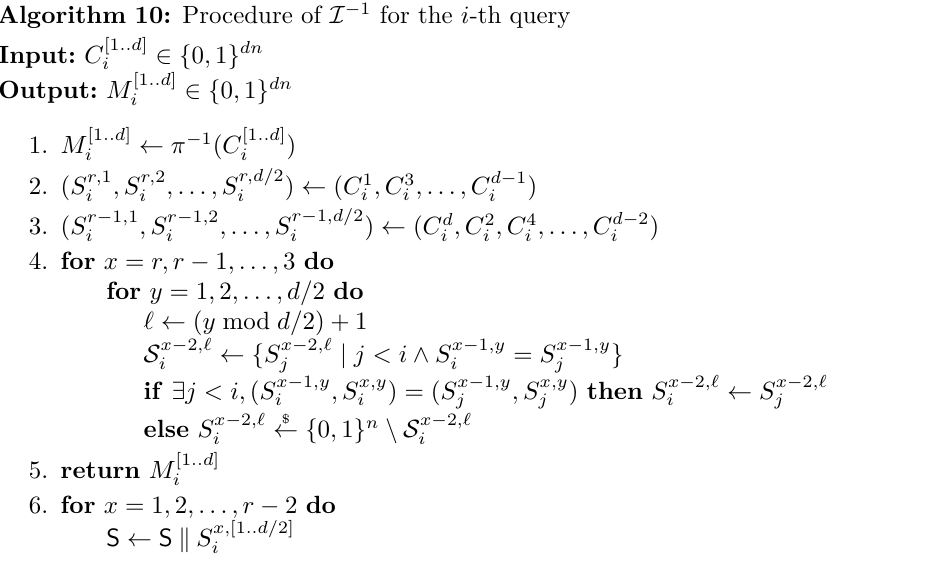
Figure 12: Definition of I and I − 1 for the SPRP proof of E 2 ,d,r . Initially, S is empty, and it is given to A after it makes all the q